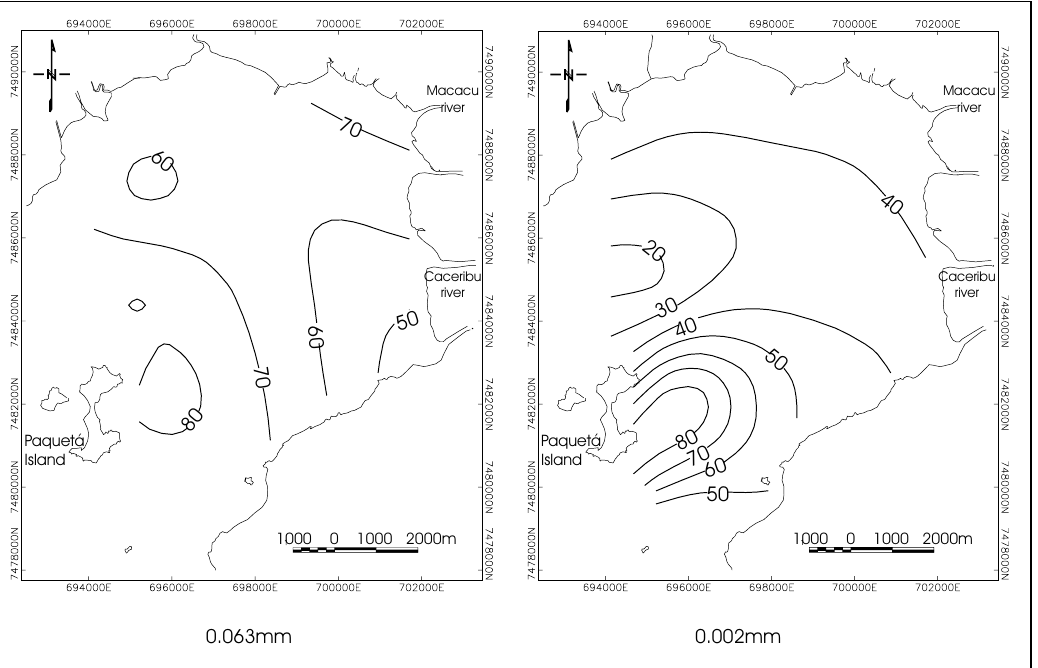
Fig. 7 – Pb distribution in bottom sediments of northeastern Guanabara Bay (contour lines are in